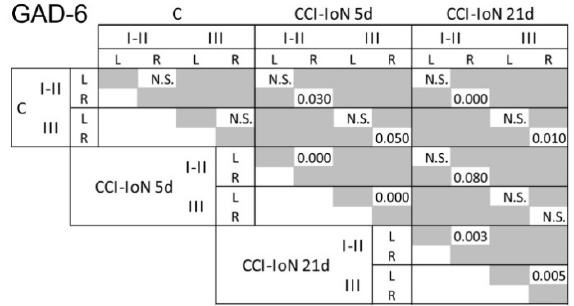
Figure 4. Results of the statistical comparisons (Kolmogorov-Smirnov D test, p -values) of densito- metric curves for GAD-6 shown in Figure 2. Similar comparisons for GlyT2 did not show any sig- nificant difference between groups. N.S., not significant.